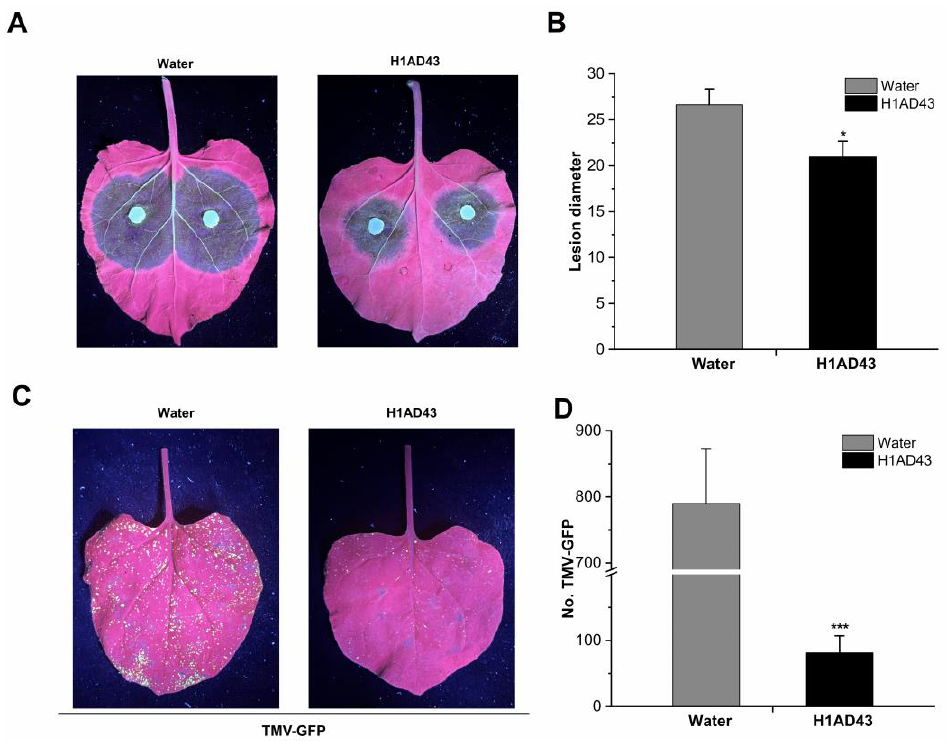
Figure 7. H1AD43 induces resistance to Phytophthora capsici and TMV in N. benthamiana . ( A ) Symp- toms of Phytophthora infection; ( B ) Diameter of diseased spots; ( C ) Typical symptoms caused by TMV-GFP in tobacco leaves; ( D ) Number of TMV-GFP diseased spots. * represents for p < 0.05 and *** represents for p < 0.001.